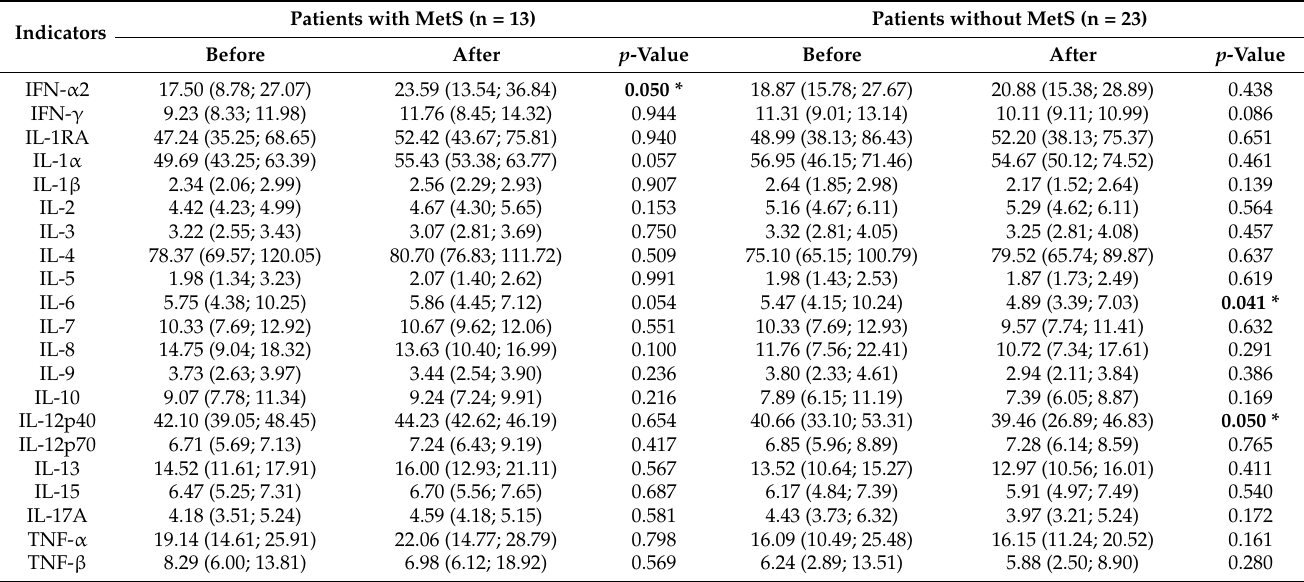
( p = 0.050) level and, in patients without MetS, to decreased IL-6 ( p = 0.041) and IL-12p40 ( p = 0.050) (Table 4). Table 4. Serum concentrations of the cytokines (pg/mL) in patients with and without MetS during 6 weeks of quetiapine or olanzapine therapy, Me (Q1; Q3).